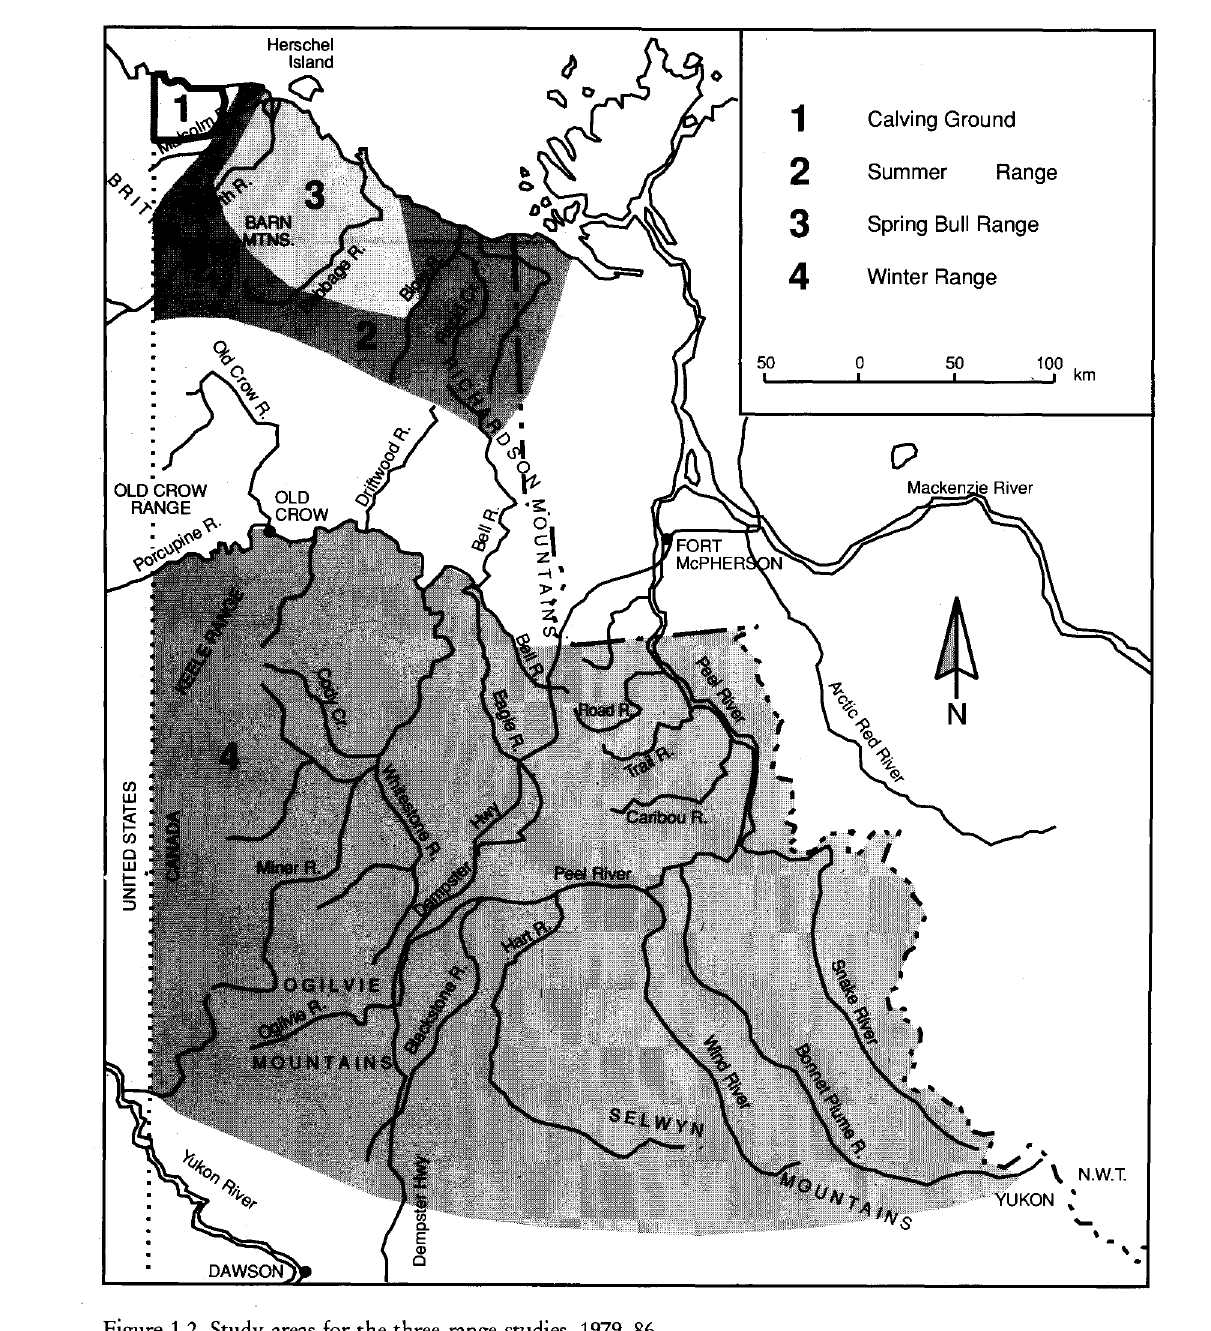
Figure 1.2. Study areas for the three range studies,